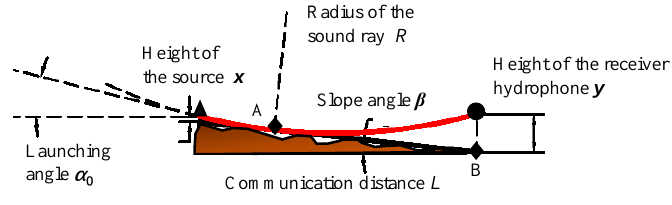
Figure 9. Schematic of the calculation